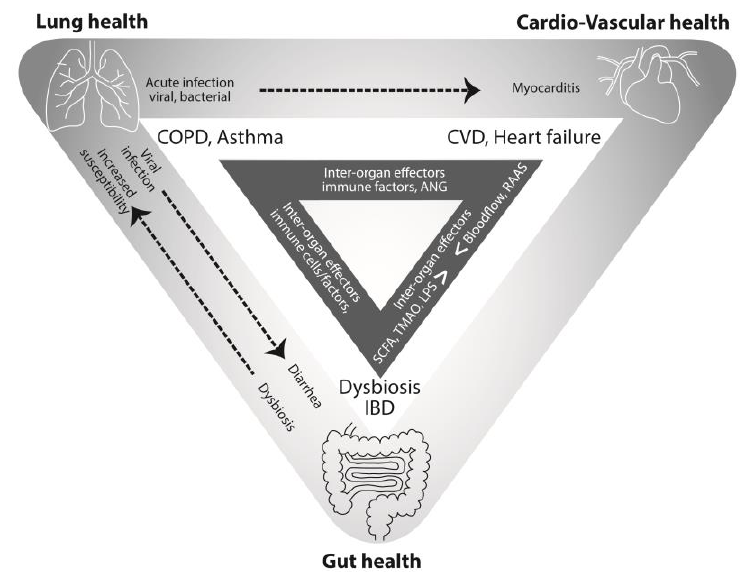
Figure 1. The interplay of lung health, cardiovascular health, and gut health. The dotted arrows indicate interorgan effects of local acute infections. The white triangle shows the main chronic conditions and the dark triangle lists some of the key effectors that enable communication.